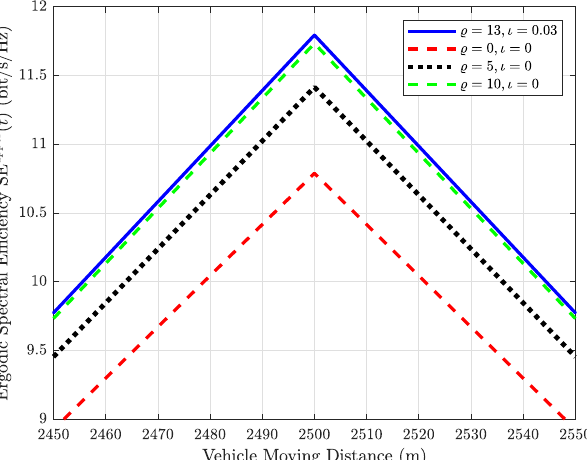
Figure 6. Ergodic SE for one vehicle pass with distance-dependent Rician factor ( (cid:36) = 13, ι = 0.03) [20], and Fixed Rician factors ( (cid:36) = 0, ι = 0; (cid:36) = 5, ι = 0; (cid:36) = 10, ι = 0 [19]). The moving distance of the vehicle is from 2450 m to 2550